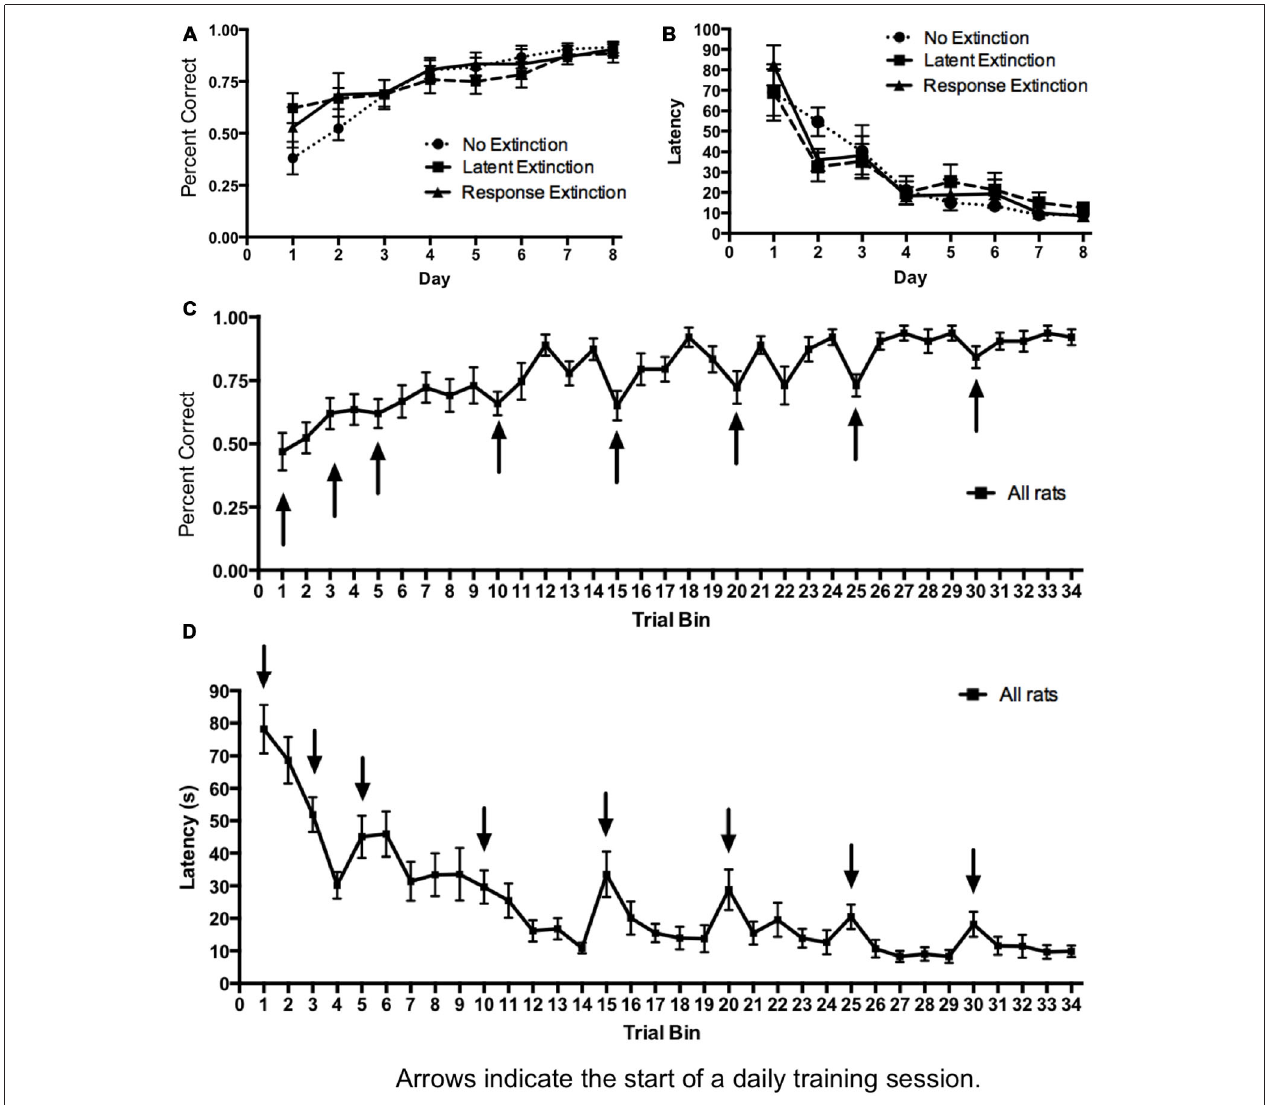
FIGURE 1 | Acquisition of hippocampus-dependent place learning in the plus-maze. (A,B) The percentage of correct turns increased (A) and the latency to reach the correct food well decreased (B) over the course of training, with no differences between groups. (C,D) Subsequently, all groups were combined, and the trials of each day were averaged into trial bins (1 trial bin = 3 trials). Animals were more likely to make incorrect turns (C) and were slower (D) on the first few trials of a given training day vs. the last few trials of the previous